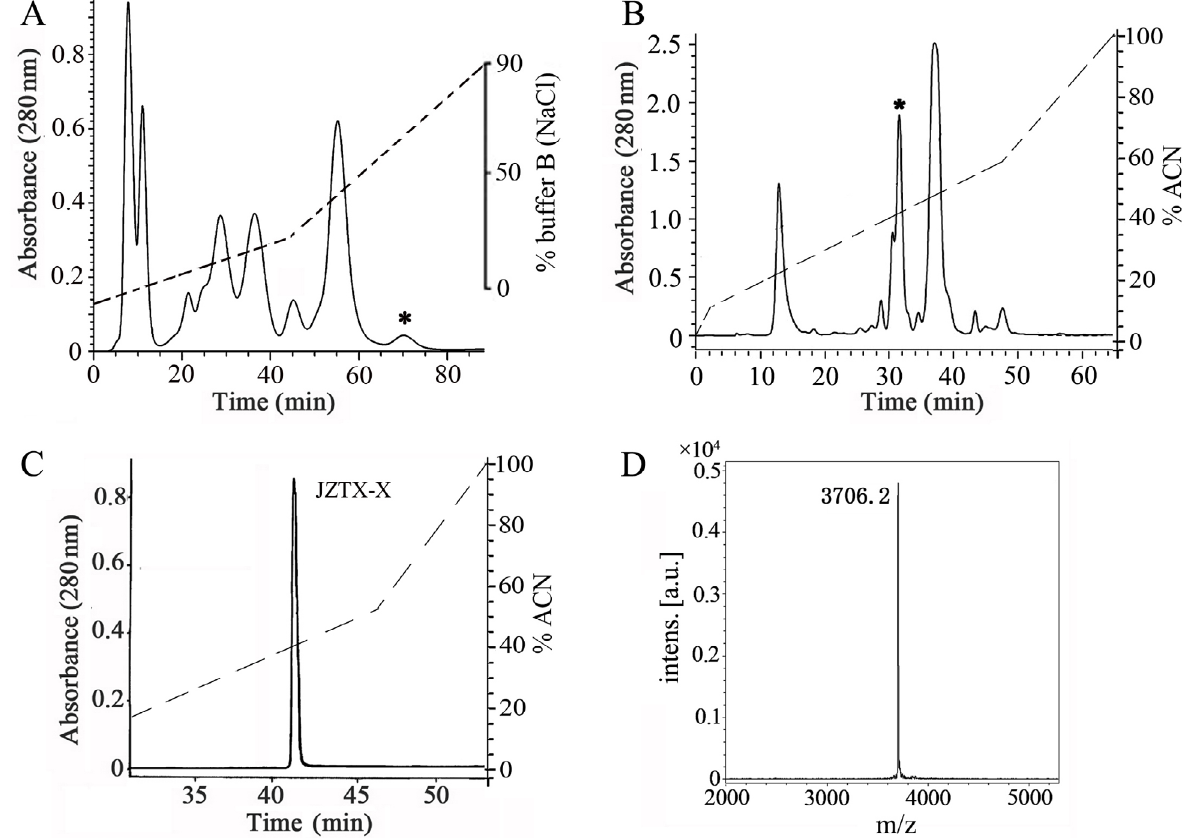
Figure 1. Purification of JZTX-X. (A) Cation-exchange HPLC elution profile of C. jingzhao venom (10 mg): Peptides and proteins were eluted with a non- linear gradient (0-90%, dashed line) of 1 M NaCl in 0.02 M sodium phosphate buffer (pH 6.25) at a flow rate of 3 ml/min and the elution profile was monitored at 280 nm. (B) RP-HPLC of the active fraction from the previous step: The C18 column was pre-equilibrated with 0.1% trifluoroacetic acid (TFA) and the peptides were eluted with a non-linear gradient (0-100%) of acetonitrile in 0.1% TFA. The asterisk (*) in (A) and (B) indicates the active peak. (C) Analytical RP-HPLC (C18 column) of purified toxin (JZTX-X): The column was pre-equilibrated with 0.1% TFA and the toxin was eluted with a linear gradient (0-100%) of acetonitrile in 0.1% TFA. The flow rate in (B) and (C) was 3 ml/min and the elution profile was monitored at 280 nm in both cases. (D) Confirmation of the purity of JZTX-X and determination of the molecular mass of the intact toxin by MALDI-TOF mass